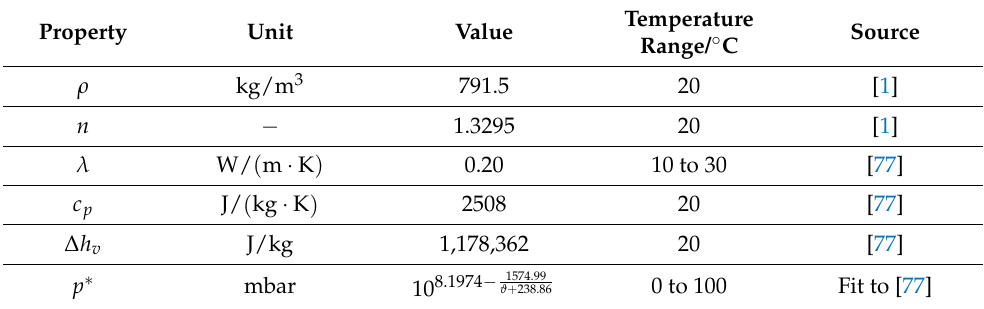
Table A1. Material properties of pure liquid methanol with ϑ being the temperature in ◦ C.